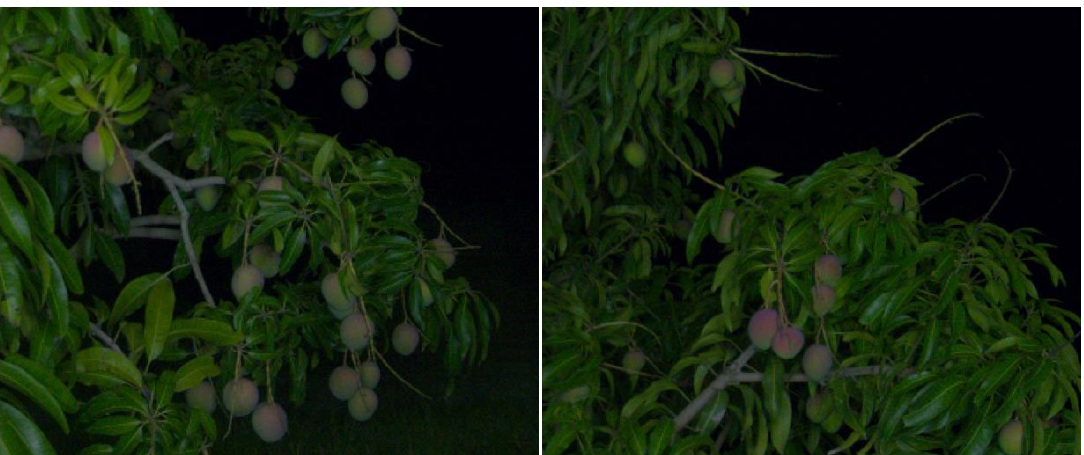
Figure 1. A partial sample of the original image.